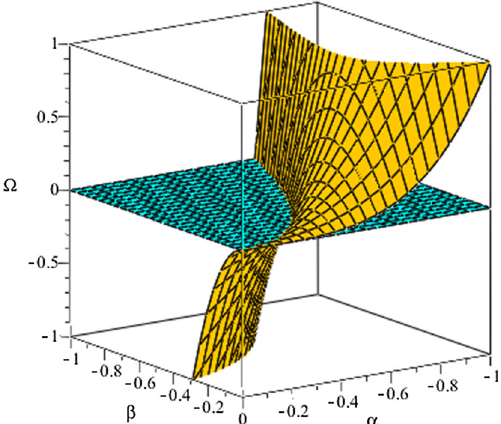
Fig. 5 The three dimensional plot of (cid:12) as a function of α and β for k =